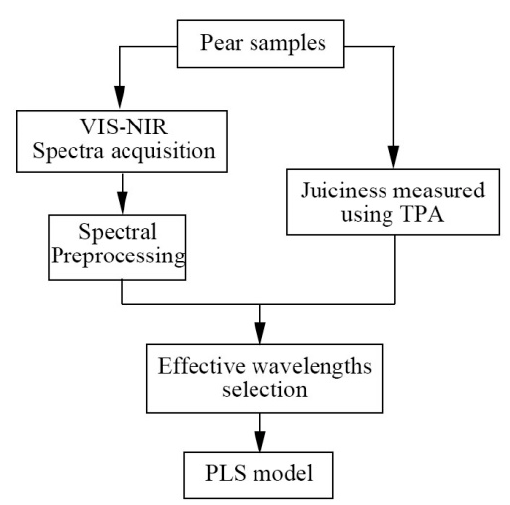
Figure 2. The flow chart of the analysis process.